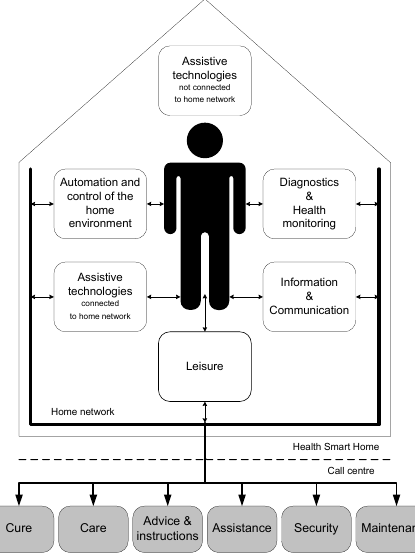
Figure 1. Various forms of technology transmitting data in an intelligent home environment. Taken and adapted from Stefanov et al. [17] as published in van Hoof et al. [18].